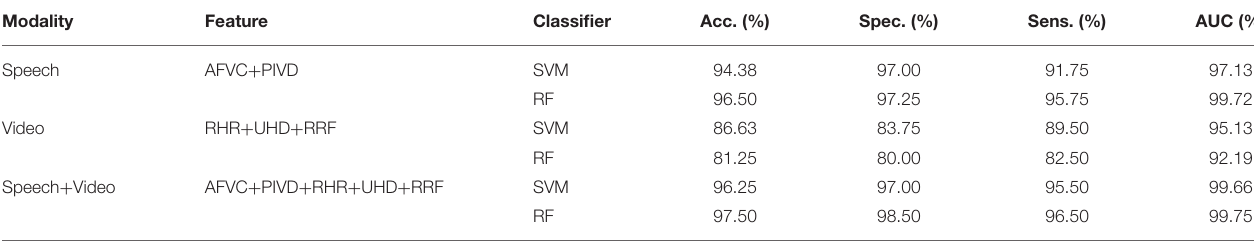
TABLE 1 | Results of the proposed automatic schizophrenic detection algorithm. Modality